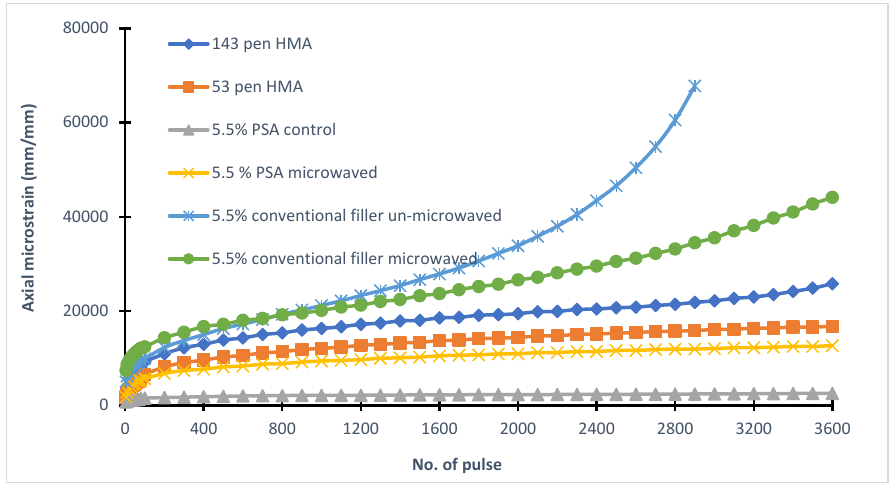
Figure 8. Correlation between accumulated creep strain and pulse count of various CBEMs.